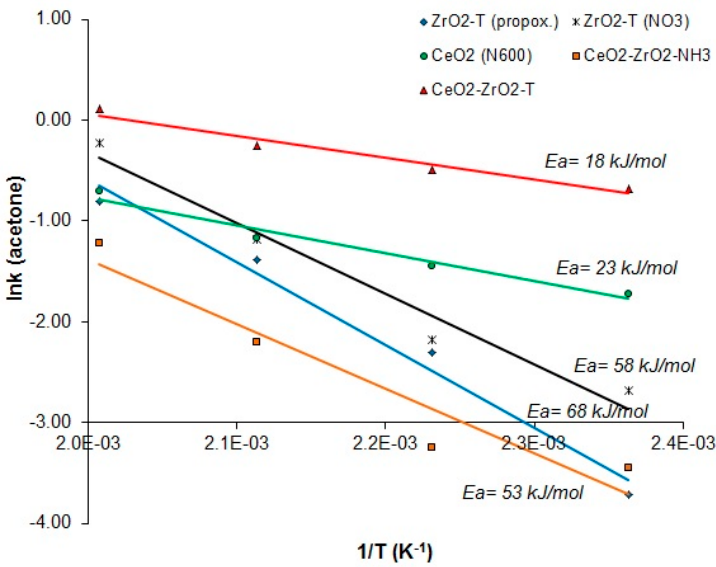
Figure 12. Arrhenius plots of the reaction rates of acetone vs 1/T for 2-propanol decomposition reaction of various catalysts.